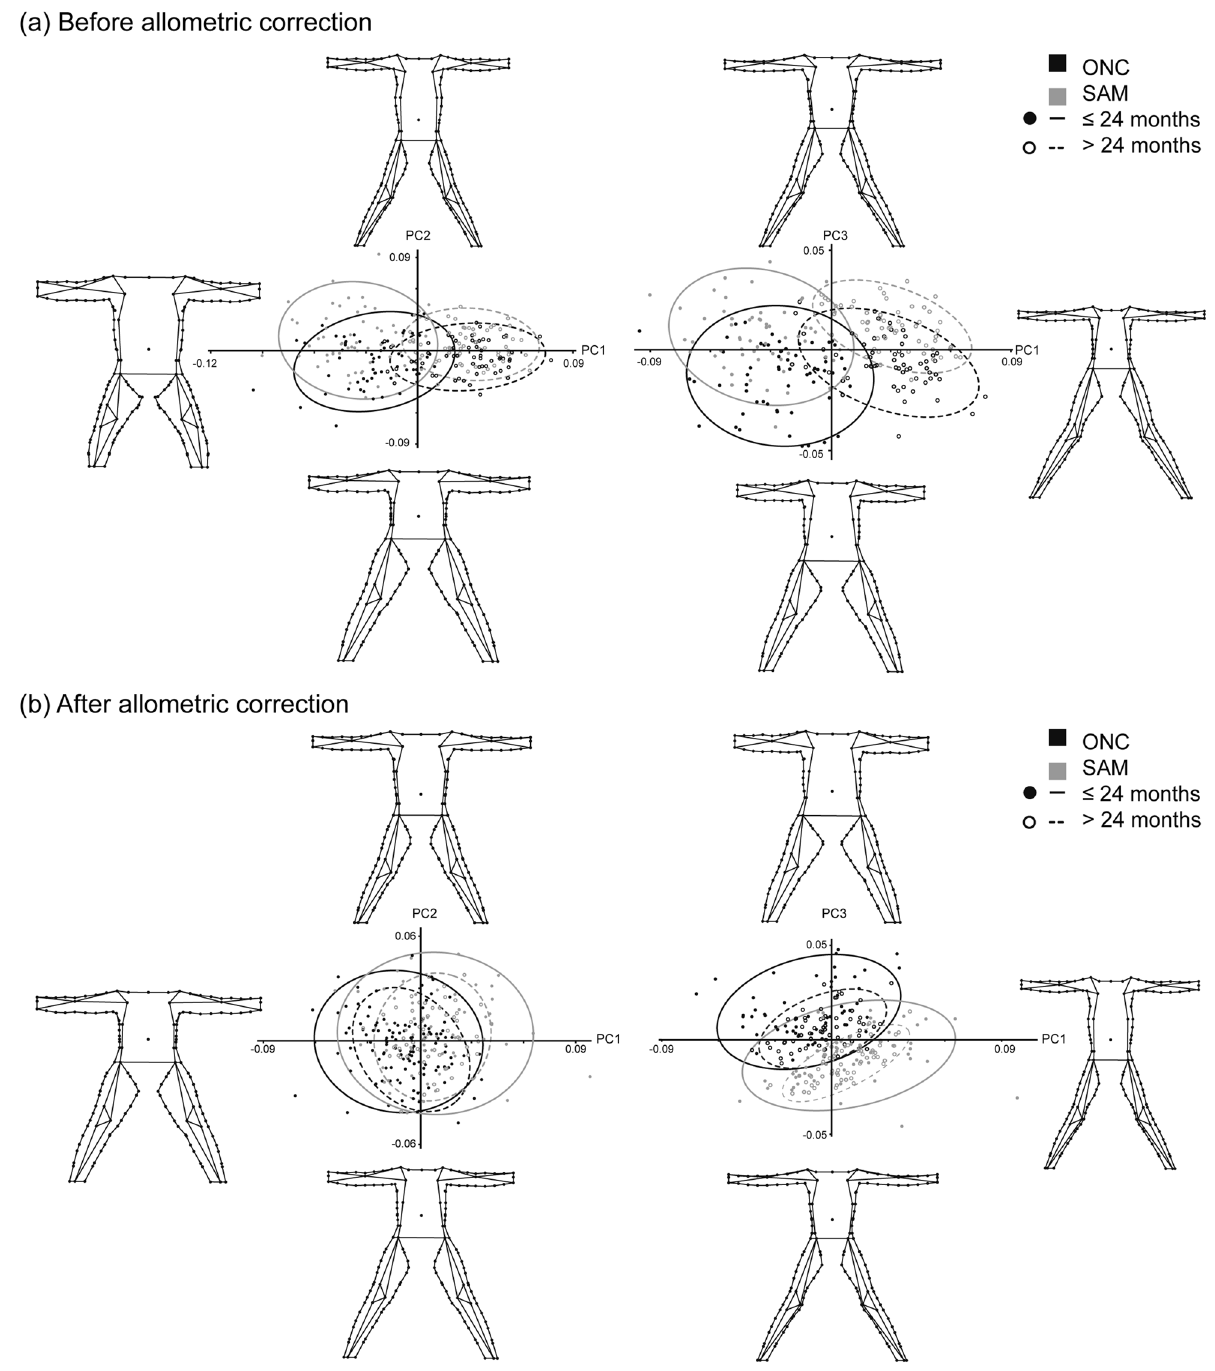
Figure 1. Shape variation of body shape in anterior view of infants and children aged 6–59 months. Principal component analysis both considering ( a ) and correcting for ( b ) allometric effect, showing main shape changes along PCs1-3. Plots of PC1 vs PC2 (left) and PC1 vs PC3 (right) exhibit the distribution of the sample according to their nutritional status, optimal nutritional condition (ONC) as black ellipses and dots and severe acute malnutrition (SAM) as grey ellipses and dots; together with age groups, under (filled dots) and over 24 months (unfilled